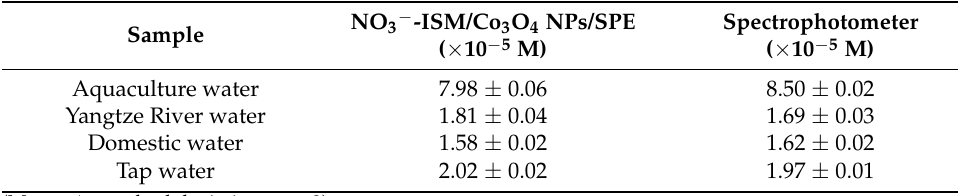
Table 3. Results from determinations of NO 3 − in an aquaponic